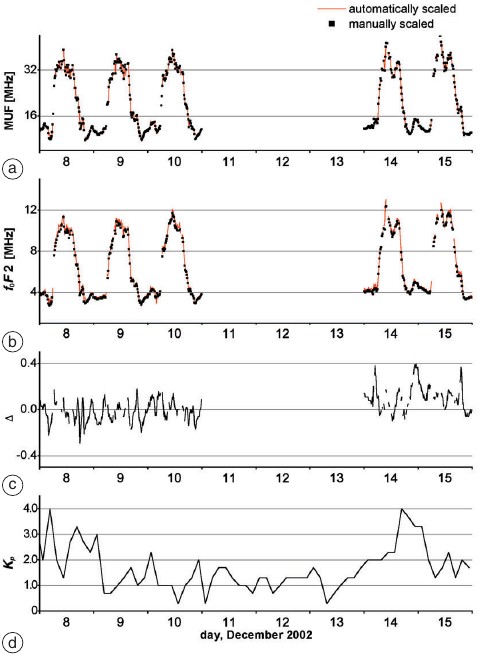
Fig. 5a-d. With reference to the days from 8 to 15 De- cember 2002: a) comparison between MUF(3000) F 2 manually scaled (black square) and automatically scaled data (red line); b) comparison between f 0 F 2 manually scaled (black square) and automatically scaled data (red line); c) plot of ∆= ( f 0 F 2 measured + − f 0 F 2 median )/ f 0 F 2 measured , used as an index of the ionospheric disturbance; d) plot of the geomagnetic activity index Kp